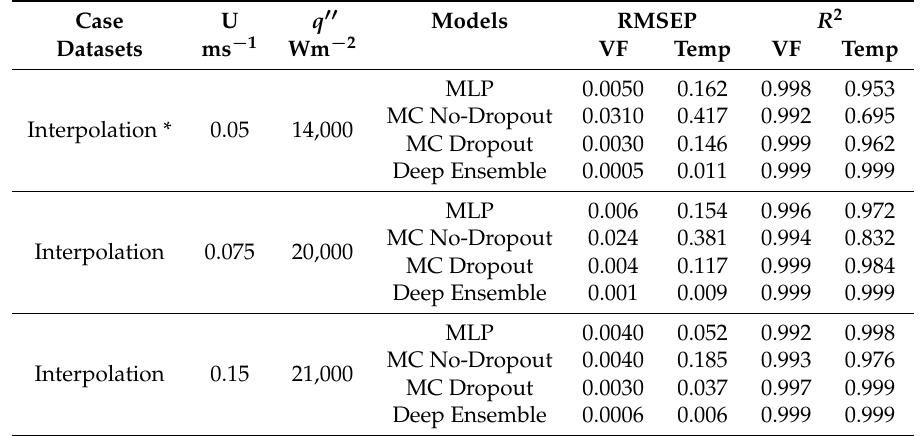
Table 6. Performance of the models on interpolation test dataset, VF: Void Fraction, Temp: Temperature. Interpolation * is the tested data presented in the